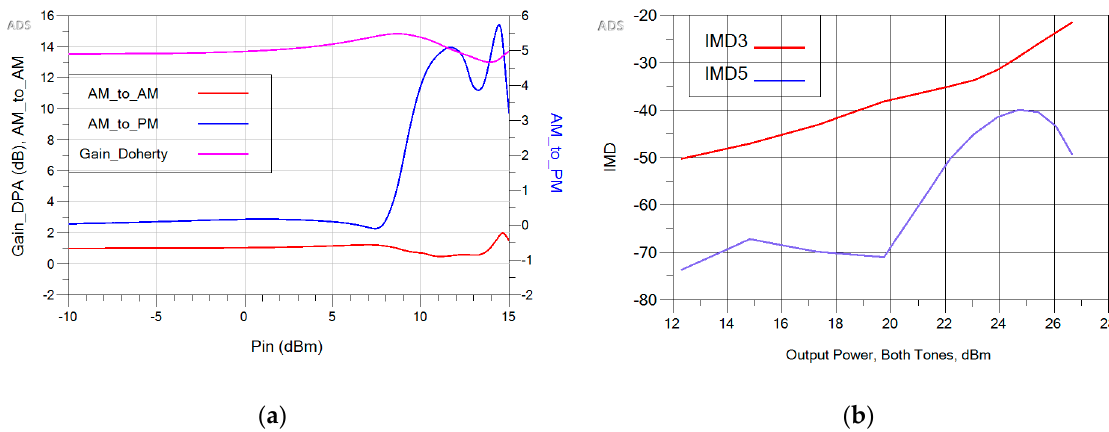
Figure 11. ( a ) The normalized AM/AM and AM/PM of the ADS-based DPA, ( b ) MD3 and IMD5 plots under the two excitations centered at a frequency of 26 GHz.